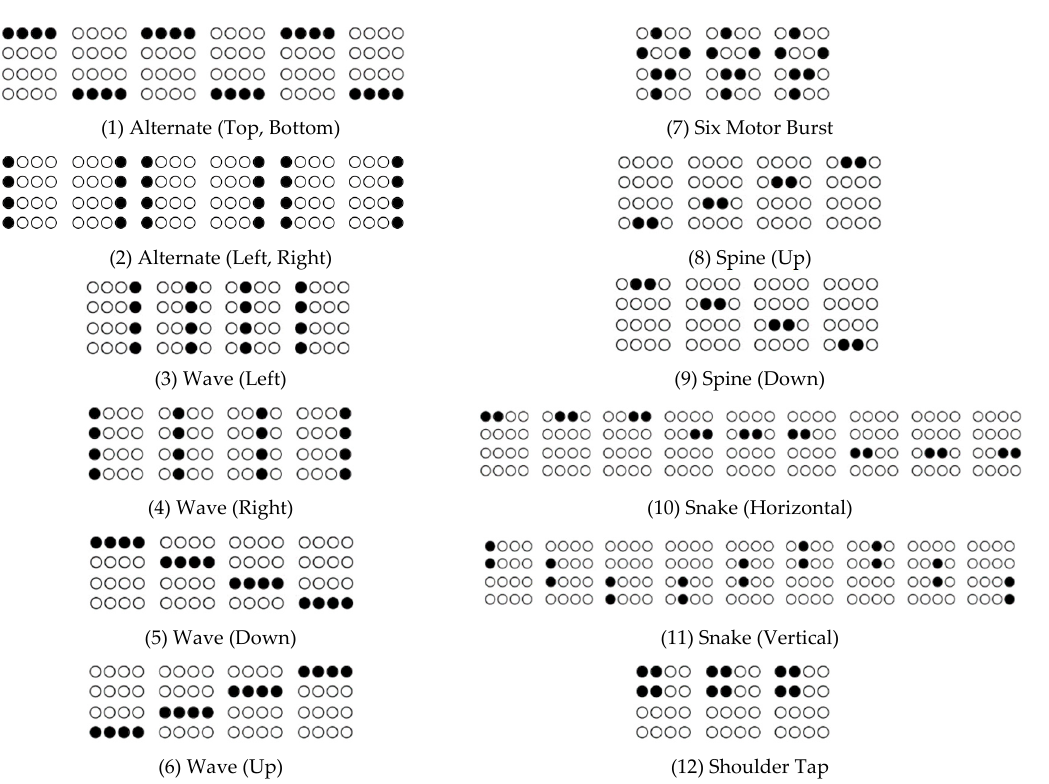
Figure 4. Maps of two-dimensional vibrotactile patterns produced by the Haptic Chair.